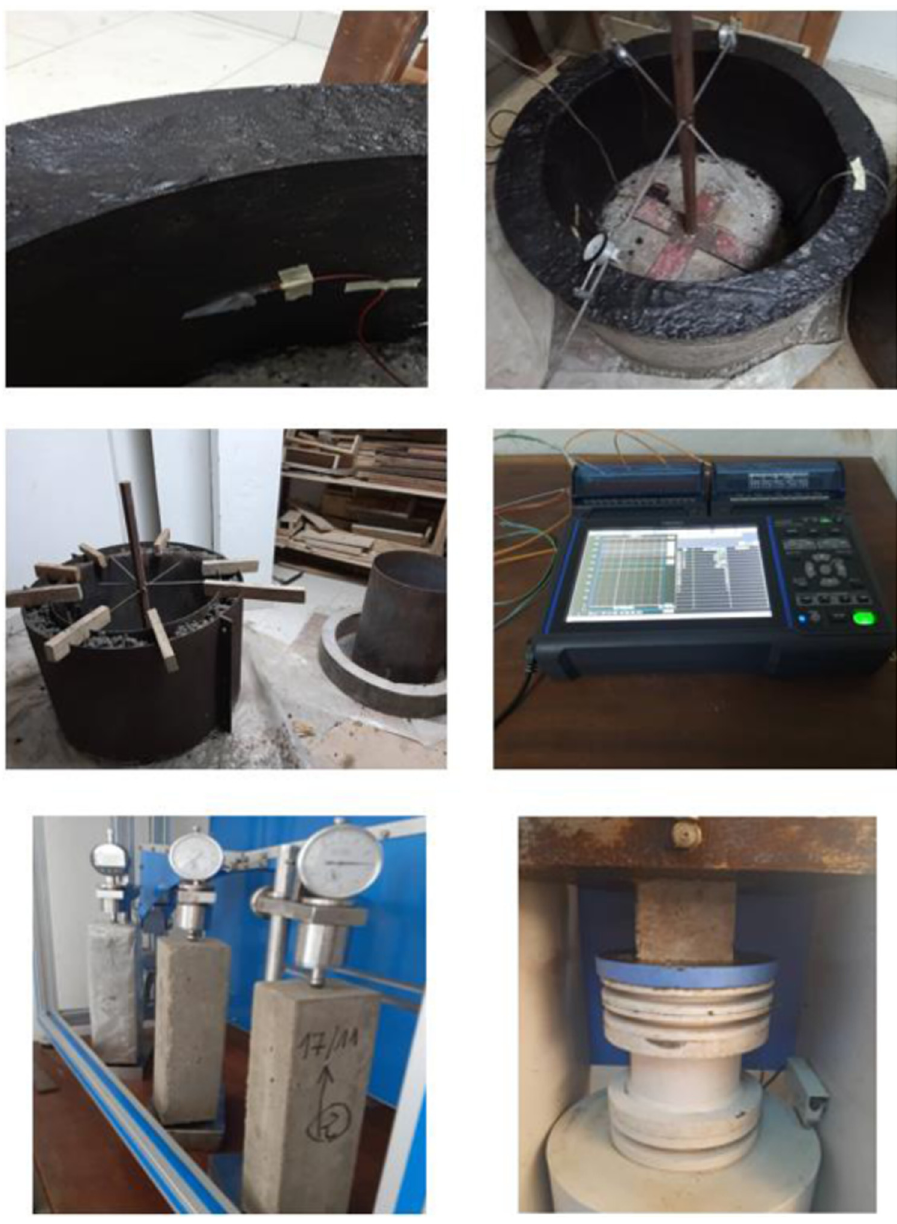
Figure 4: Sample preparation and instrumentation.